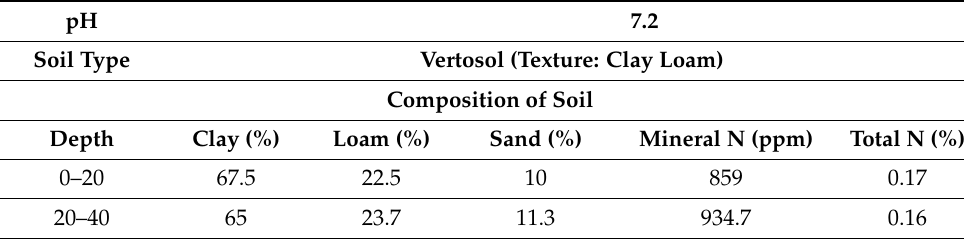
Table 2. The soil’s physicochemical characteristics of Oued Beja station. pH 7.2 Soil Type Vertosol (Texture: Clay Loam) Composition of